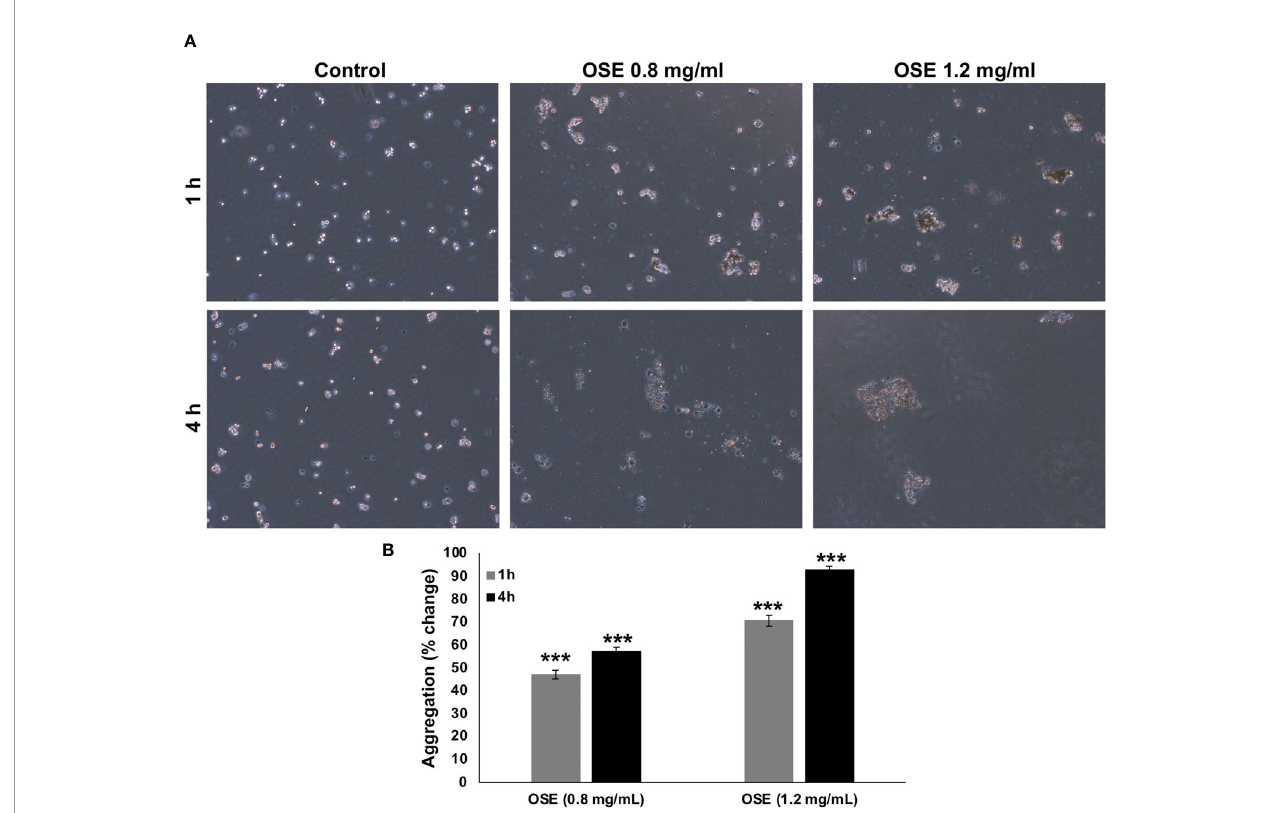
FIGURE 5 | OSE promotes MDA-MB-231 cell-cell aggregation. (A, B) Cells were incubated with or without OSE treatment (0.8 and 1.2 mg/ml) for 1 or 4h and subjected to aggregation assay. Percentage aggregation was calculated according to the following formula: % aggregation = (1-Nt/Nc) x 100, where Nt and Nc represent the number of single cells in OSE-treated or control groups respectively. Values are represented as mean ± standard error of the mean (SEM) of three independent experiments (***p < 0.001).